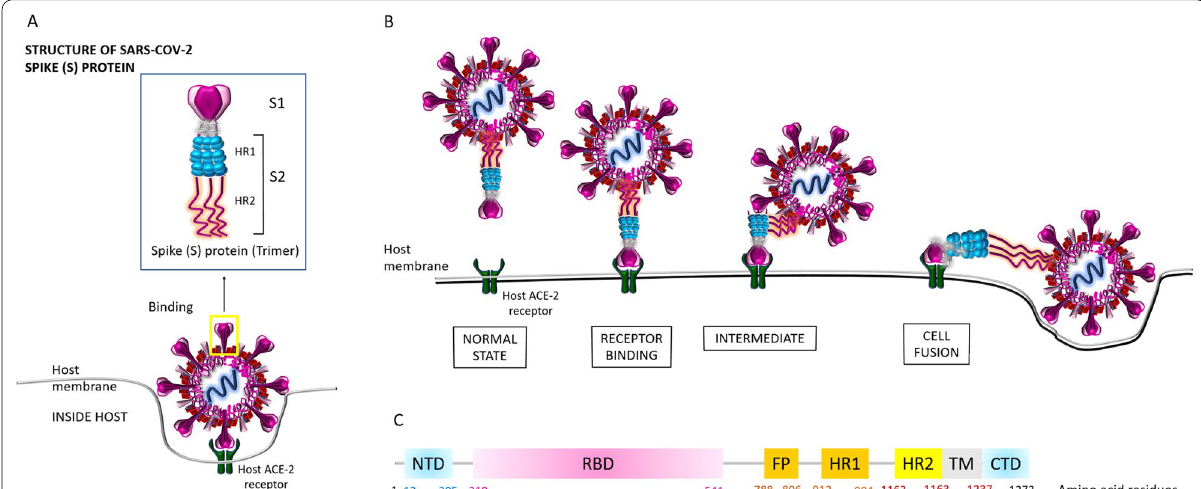
Fig. 2 SARS-CoV-2 spike (S) protein structure. A The binding mechanism of the host ACE-2 receptor by the SARS-CoV-2 spike (S) protein which has 1273 amino acid residues (180–200 kDa) has been shown. S protein trimers are the crown-like halo structures surrounding the viral particle. The S1 and S2 subunits form the bulbous head and stalk region (Noor and Maniha 2020). B Binding of the host ACE-2 receptor with the SARS-CoV-2 spike protein leading toward the viral fusion within the host has been shown. Indeed, different conformations of the spike (S) RBD domain in opened and closed states function in this mechanism which has been elaborately discussed by Huang et al. (2020) (not shown in this diagram). C Amino acid alignment within the SARS-CoV-2 Spike (S) protein. The S protein contains (1) the extracellular N-terminus domain (amino acids 1–13), (2) the S1 subunit (14–685 residues), and (3) the S2 subunit (686–1273 residues): the fusion peptide (FP) (788–806 residues) plus the heptapeptide repeat sequence 1 (HR1) (912–984 residues) and HR2 (1163–1213 residues); a transmembrane (TM) domain (1213–1237 residues) across the viral membrane, one region for receptor binding and one for membrane fusion; and finally, an intracellular C-terminal domain (CTD/ cytoplasm domain (1237–1273 residues) (Noor and Maniha 2020). As stated earlier, the RBD situated in the S1 subunit binds to the cell host ACE2 receptor (Kahn and McIntosh 2005). Besides, FP is actually a short segment of 15–20 conserved hydrophobic amino acid residues (mostly glycine alanine), which mediates the anchoring of the target membrane when the S protein adopts the conformation (Huang et al. 2020). Moreover, this is noteworthy that the targeting the heptad repeat (HR) has attracted the greatest interest in therapeutic drug discovery so far (Noor and Maniha